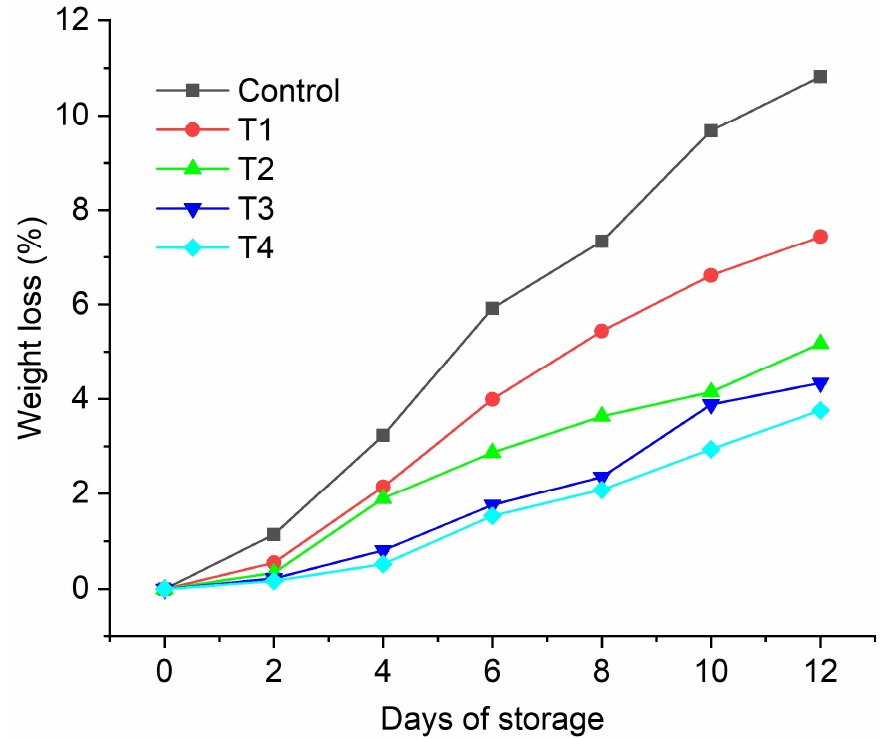
Figure 2. Effect of edible coatings on weight loss of Ficus carica fruits: uncoated control, AVG (T1), AVG + glycerol (T2), AVG + glycerol + anthocyanin + 0.2% (T3), AVG + glycerol + anthocyanin + 0.5% (T4). Data are presented as mean ± SD, ( n = 3) (error bars are significantly smaller than the data points).